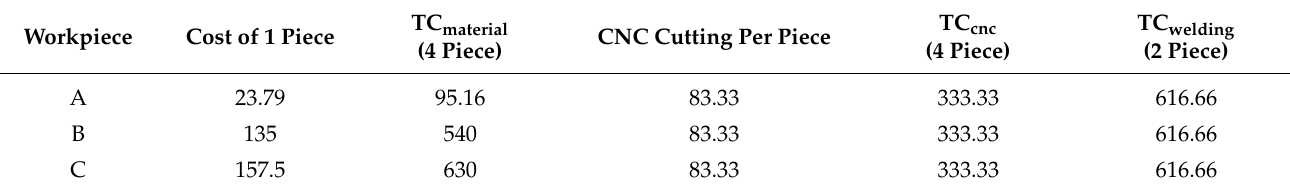
Table 5. Cost calculations for